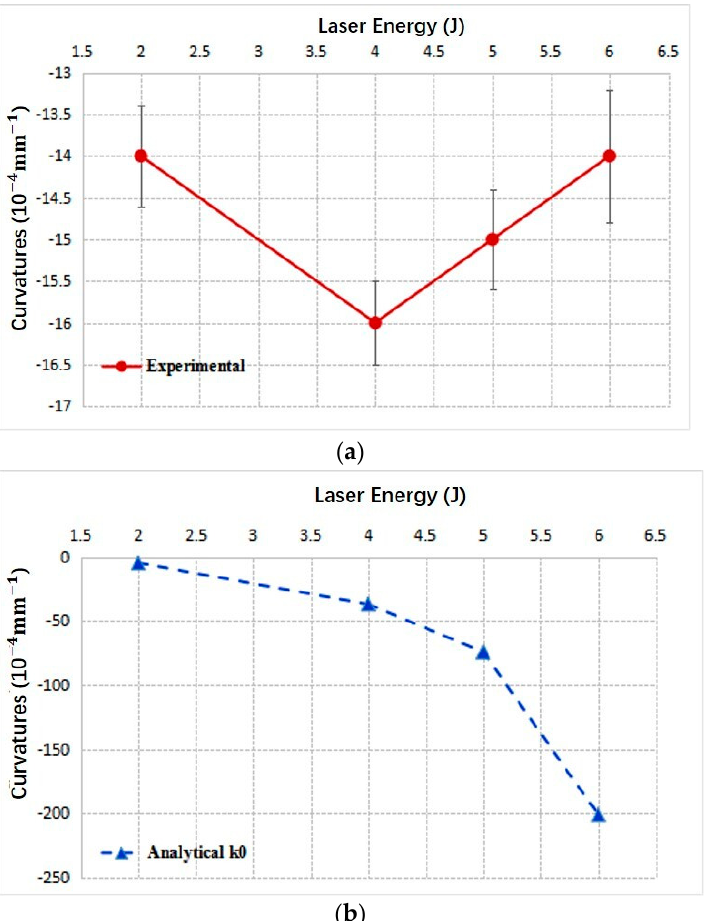
Figure 10. Curvatures of 2 mm 2024 aluminum alloy vs. laser pulse energies: ( a ) experiment ( b ) analytical model.